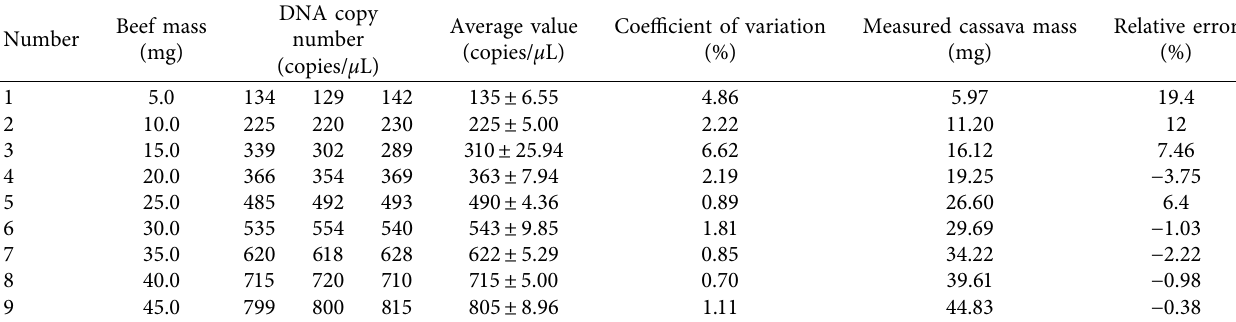
Table 2: Detection by digital PCR of mixed samples with known adulteration ratios.